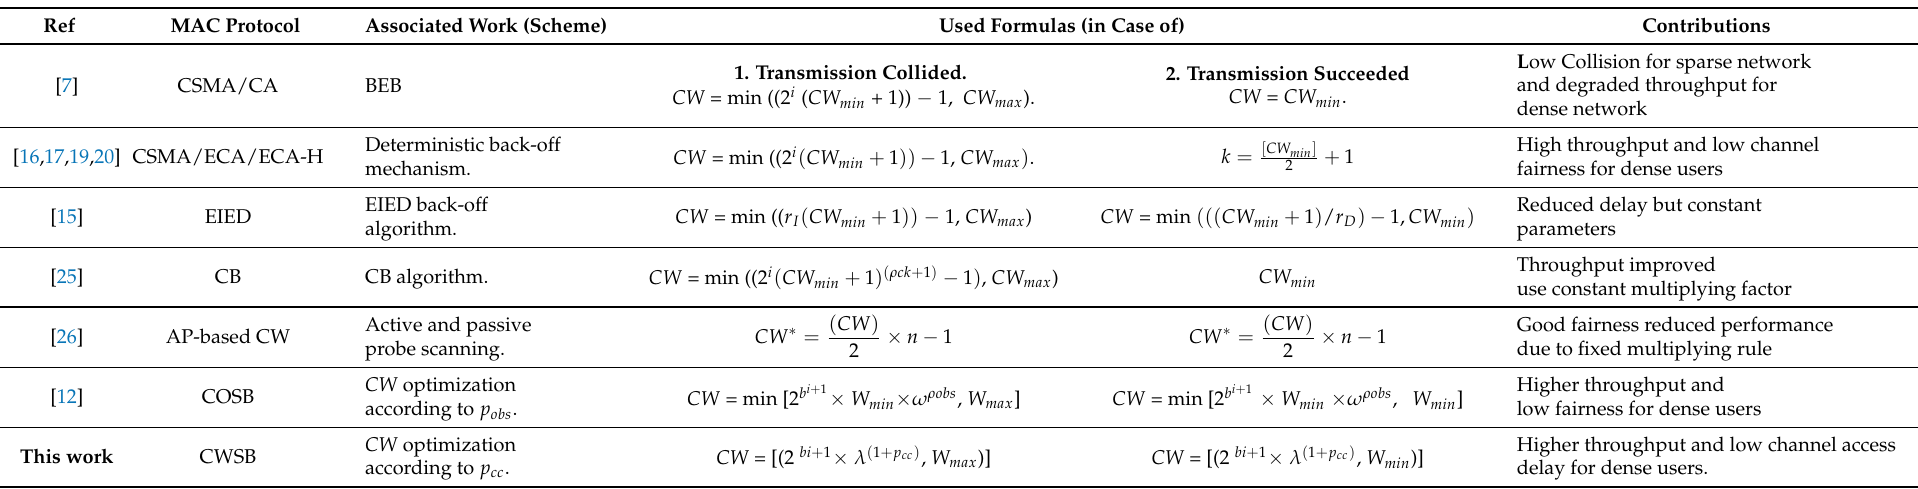
Table 1. Summary of related